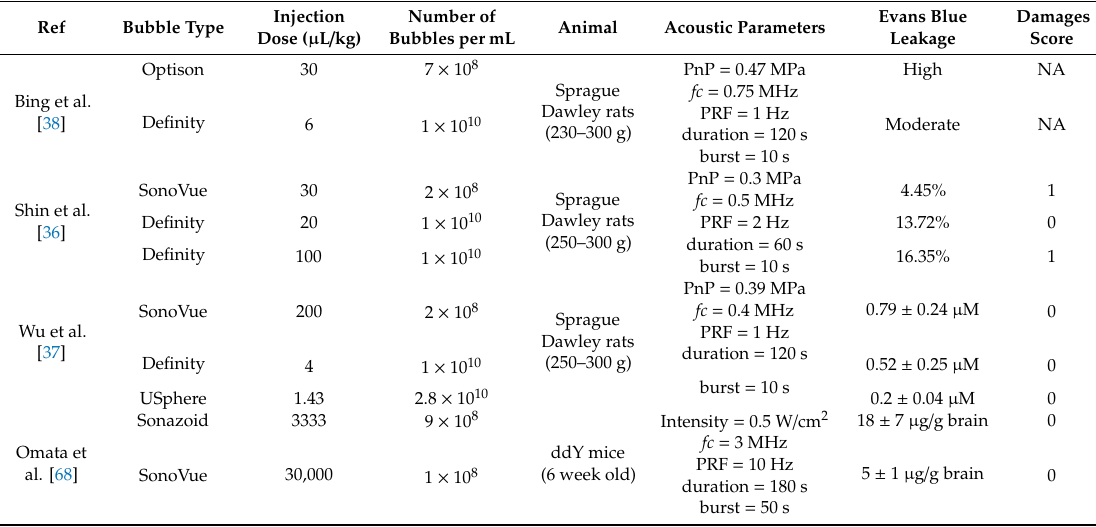
Table 2. Comparison of di ff erent commercial bubbles regarding BBB